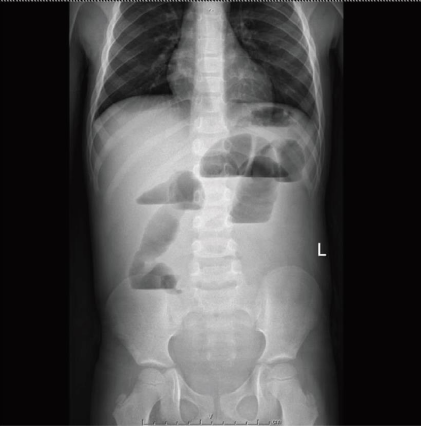
Figure 1: Abdominal X-ray. X-ray showing multiple air-fuid levels, which is suggestive of bowel